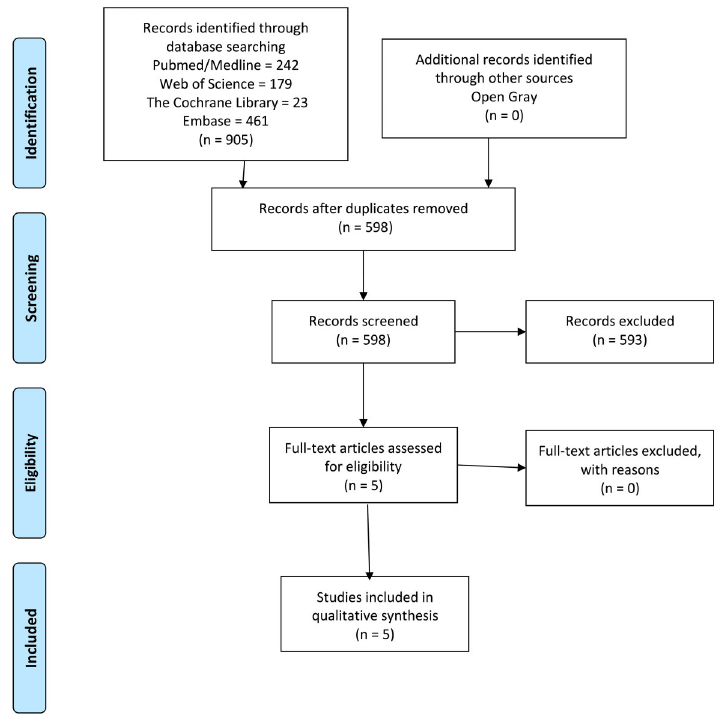
Figure 1. PRISMA fl ow diagram of study